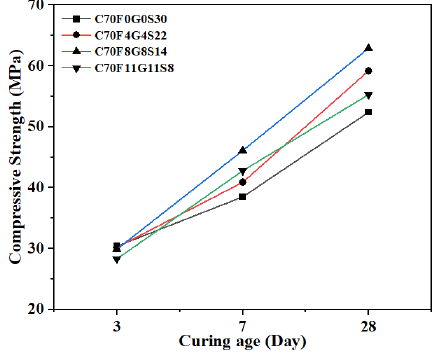
Figure 8. Group SSP Compressive Strength.